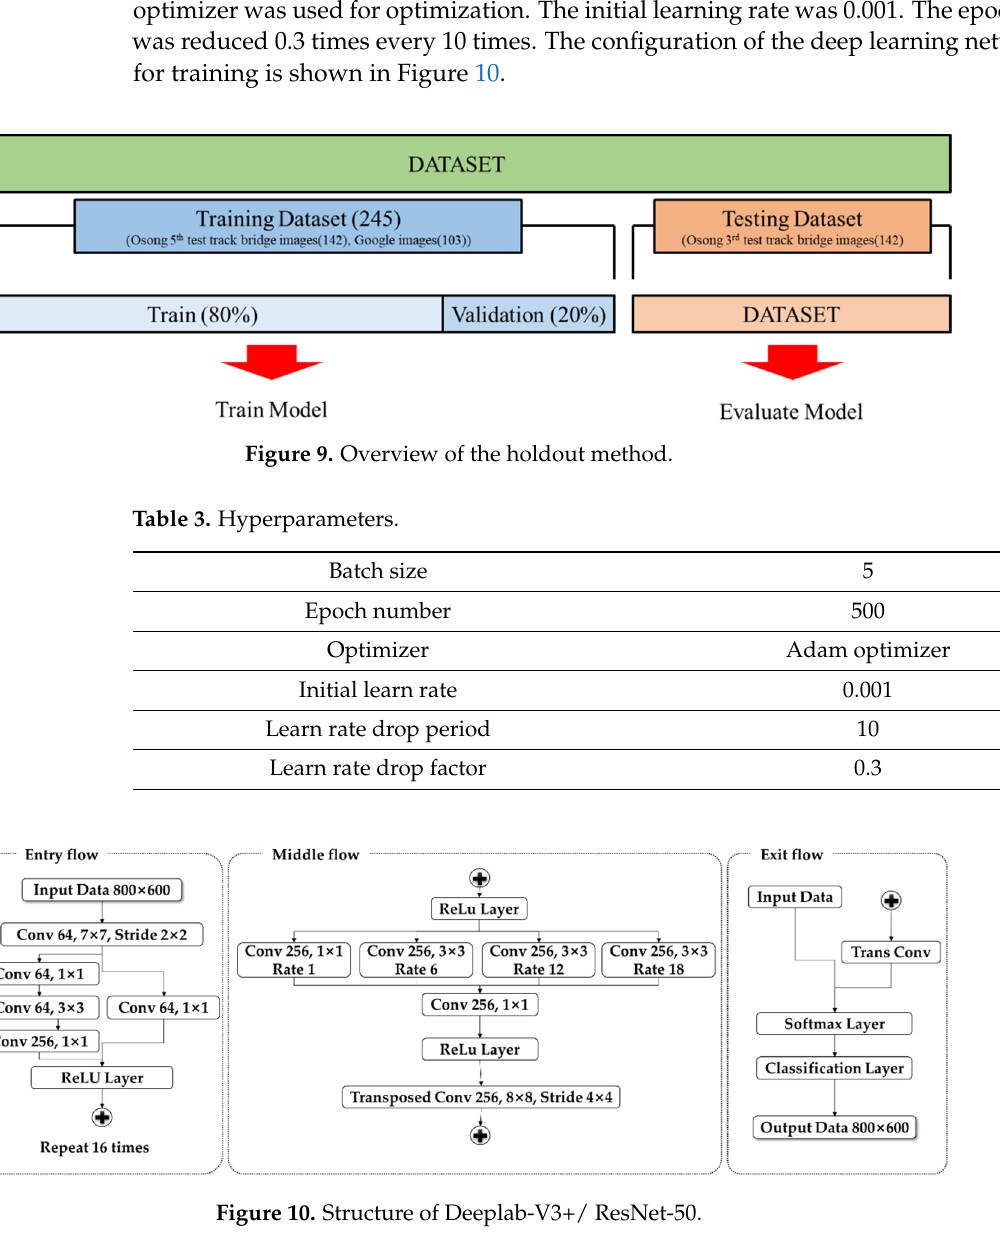
Figure 11. Principle of the SfM photogrammetry. The SfM technique, which generates a 3D point cloud model using 2D images, finds location and geometry information by utilizing key points common in several images. Key points are matched from SIFT using image intensity information. In this study, a method of overlaying label data, semantic information on photography data, was used to reflect both location information and semantic information. The key point was found using the intensity information of the original photography data. 3D location information was ob- tained for each pixel of the image. After finding the location information, the semantic information was transformed to an RGB value and visualized with a transparency of 50% over the original image data. Through this process, it was possible to visualize the 3D PCD of the bridge together with the bridge component information. 4. Validation Test To verify the performance of the proposed SSfM system, an experiment was carried out using the test data collected from the Osong 3rd test track in Osong-eup, Heungdeok- gu, Cheongju-si, Chungcheongbuk-do, Korea. A total of 183 test data were collected from